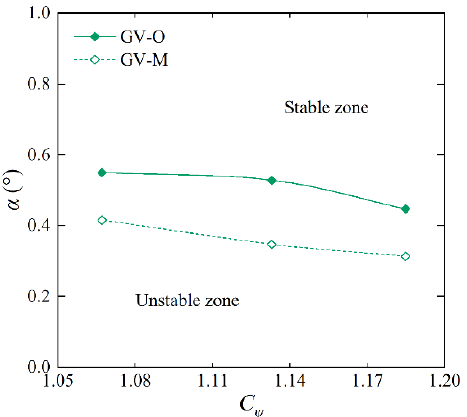
Figure 22. Critical opening angles vs. head coefficient for GV-O and GV-M.